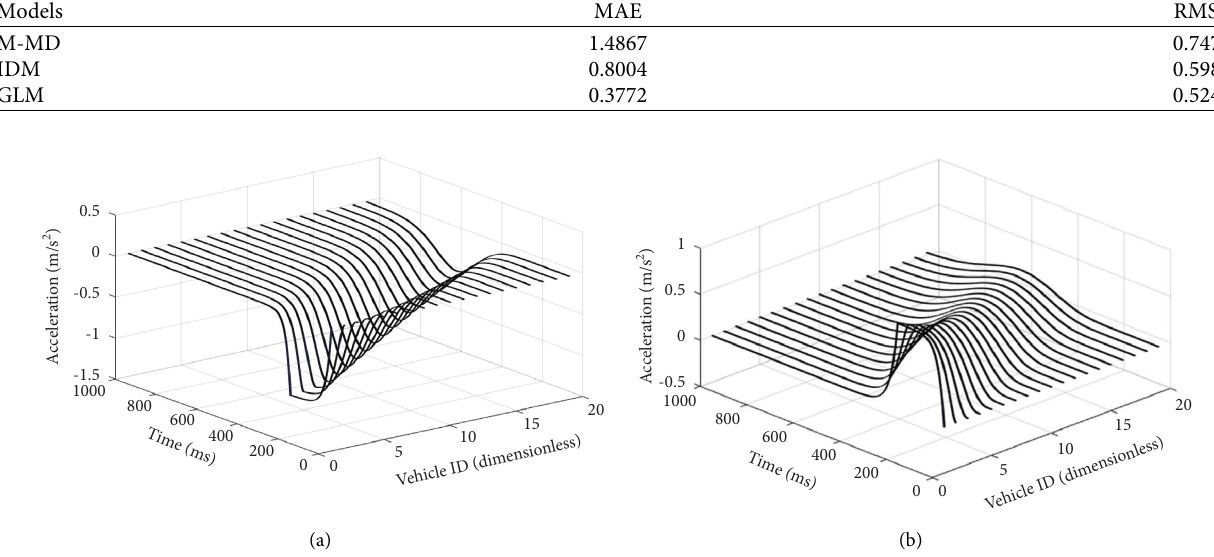
Figure 9: Time-acceleration figure obtained from model simulation. (a) The leader of the simulation fleet is disturbed by deceleration. (b) The leader of the simulation fleet is disturbed by acceleration.